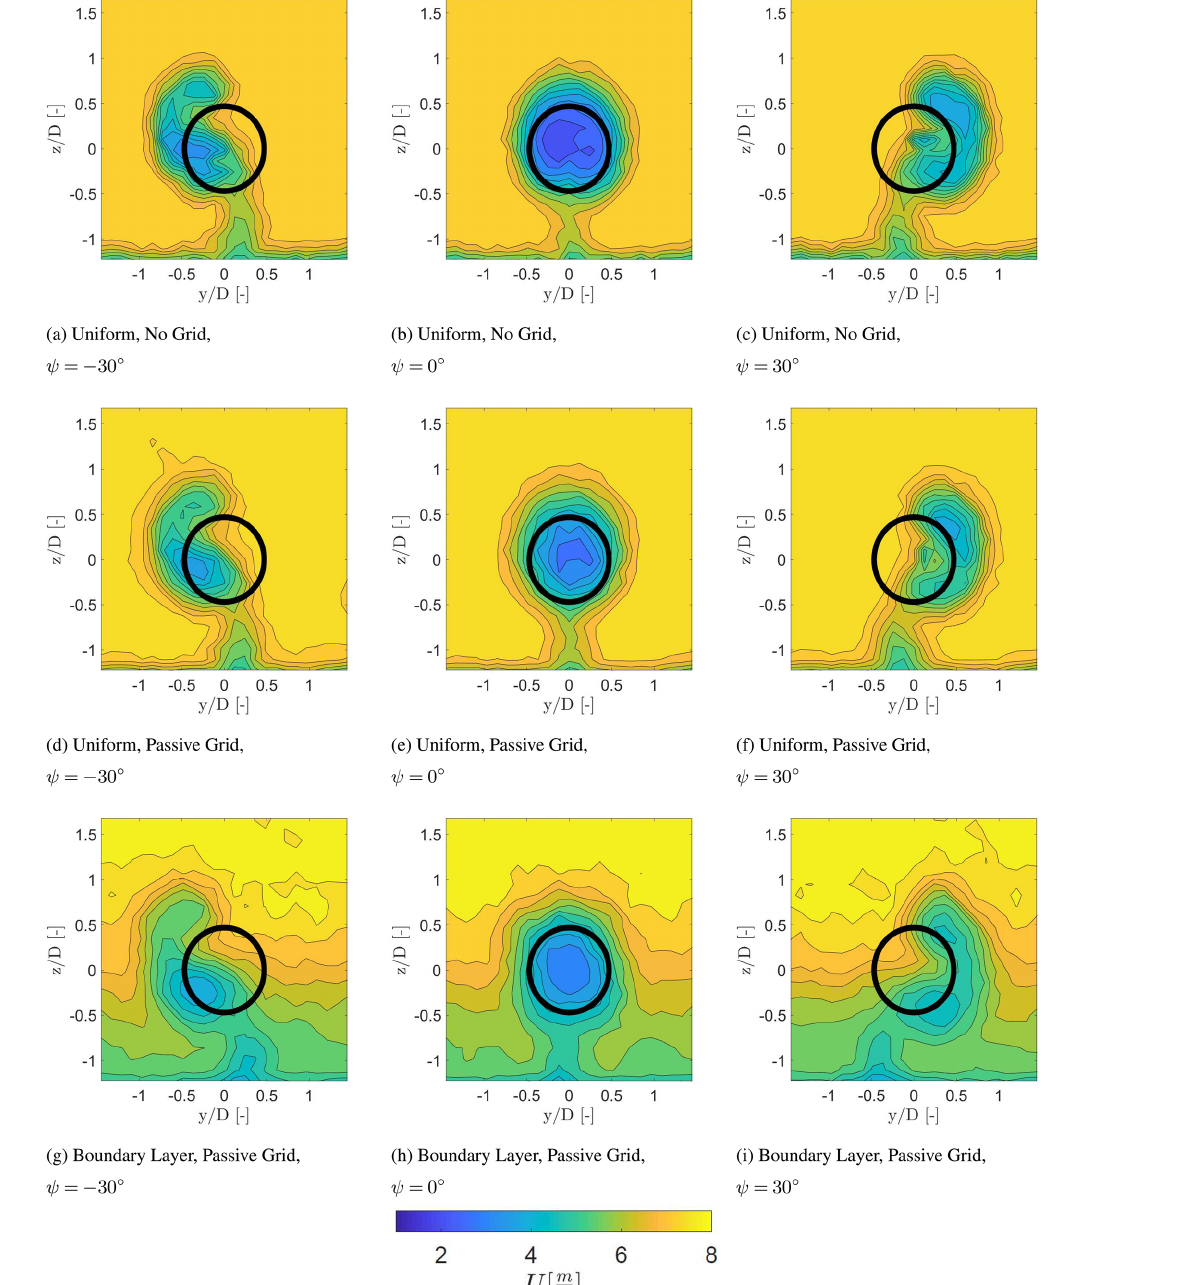
Figure 5. Temporally averaged streamwise velocity component at a downstream distance of 5 D for different inflow conditions. The wake is viewed looking upstream towards the turbine